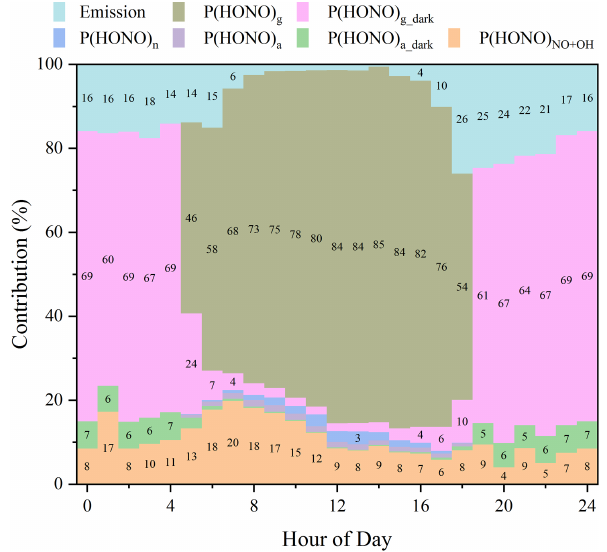
Figure 9. Relative contributions of different HONO sources. Note that the contribution from direct emission was calculated based on the ratio of HONO emi to the observed